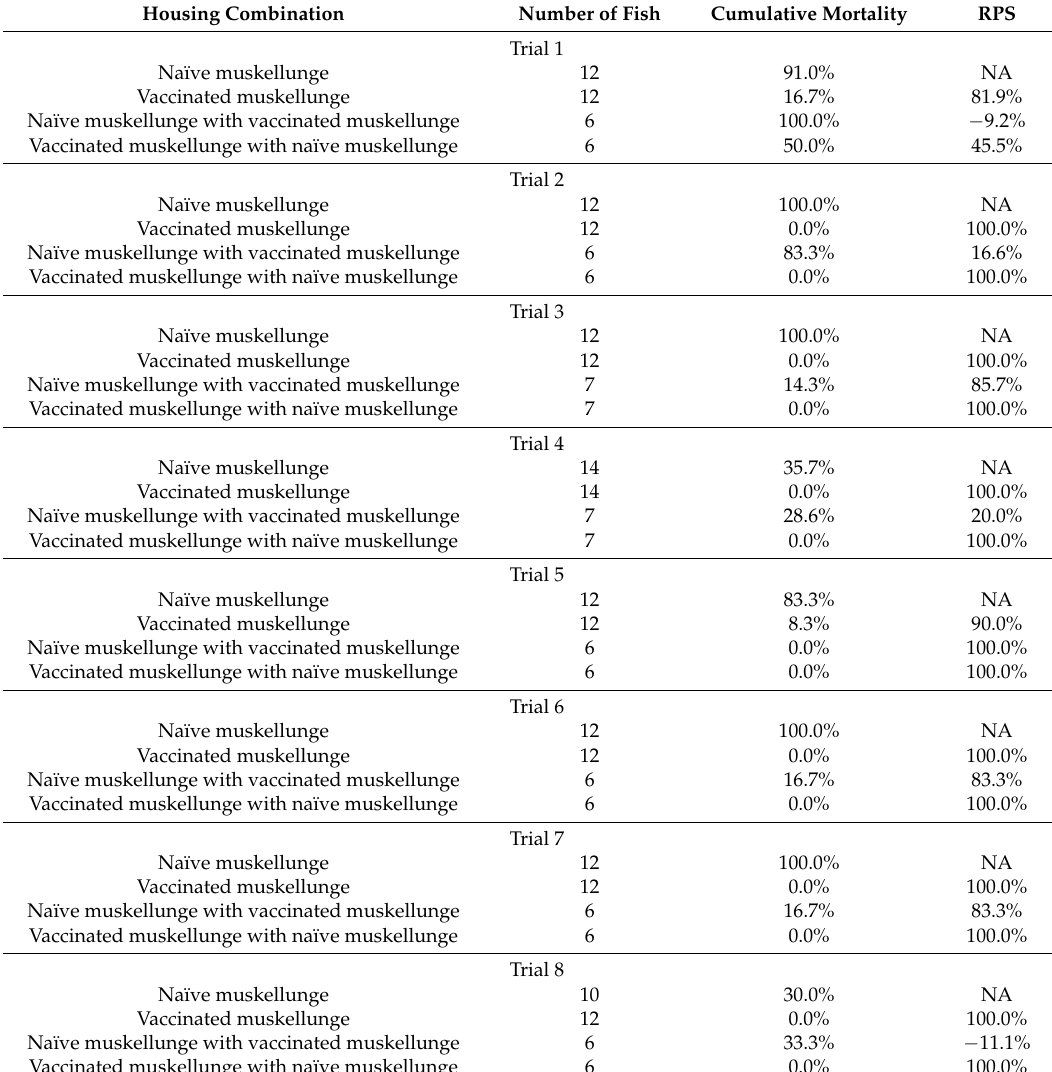
RPS are assessed separately. NA: not